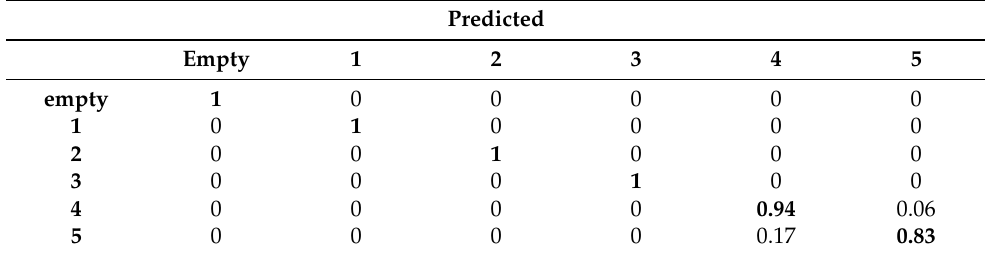
Table 1. Confusion matrix in room A with maximum 5 people and Naïve Bayes classifier.